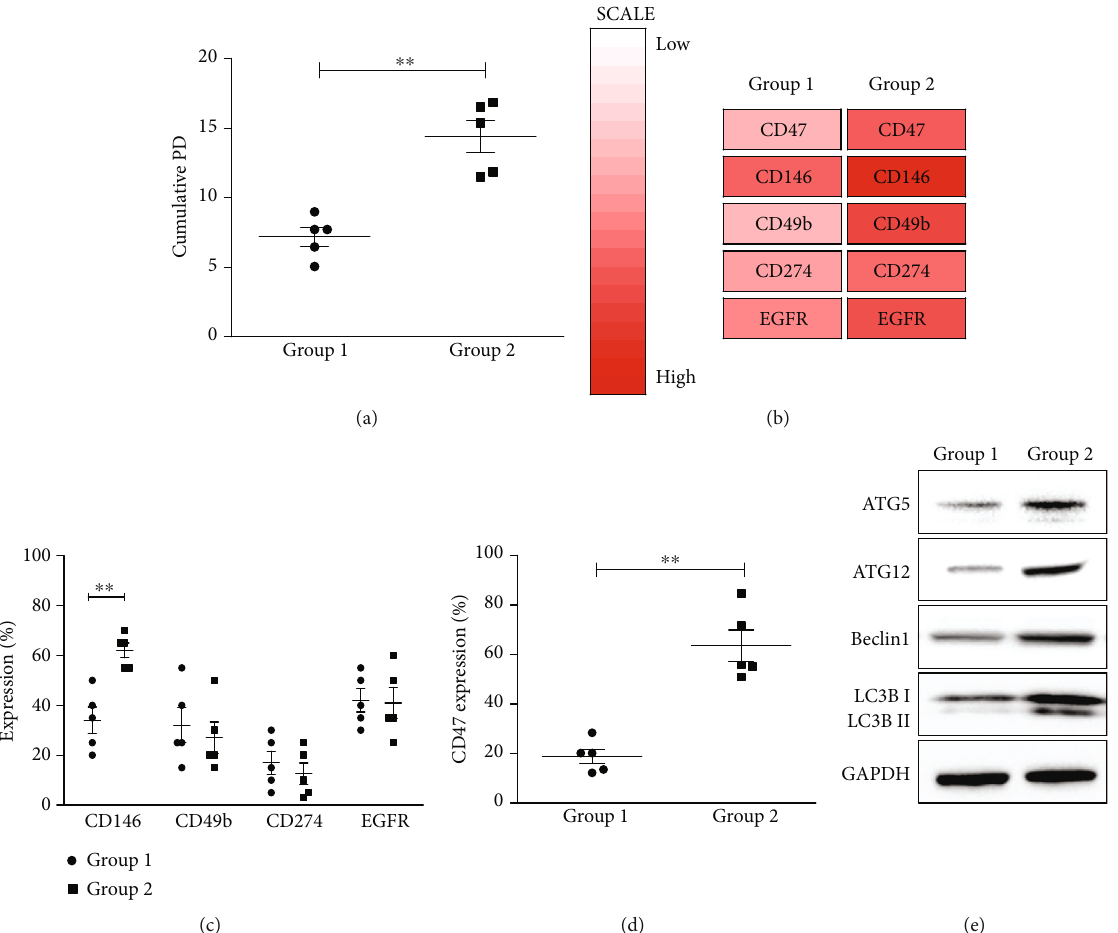
Figure 1: Screening results revealed di ff erent CD47 expressions on two groups, depending on cellular proliferation. (a) Comparative results of cumulative population doubling (CPD) at passage 5 showed higher proliferative capacity on Group 2. (b) Screening for cell surface proteins between two groups was shown with heat map analysis based on 242 cell surface antibody screening. The signi fi cant di ff erence in cell surface antigen expression between two groups was revealed: CD47, CD146, CD49b, CD274, and EGFR. (c, d) Flow cytometry identi fi ed two CD markers (CD146 and CD47), showing signi fi cant di ff erence expression. (e) Immunoblotting results demonstrated that the expression of autophagy-related proteins, ATG5, ATG12, Beclin1, and LC3B, downregulated on Group 1. Data is expressed as the mean ± SD ; n = 5 ; ∗∗ p < 0 : 01 , ∗ p < 0 : 05